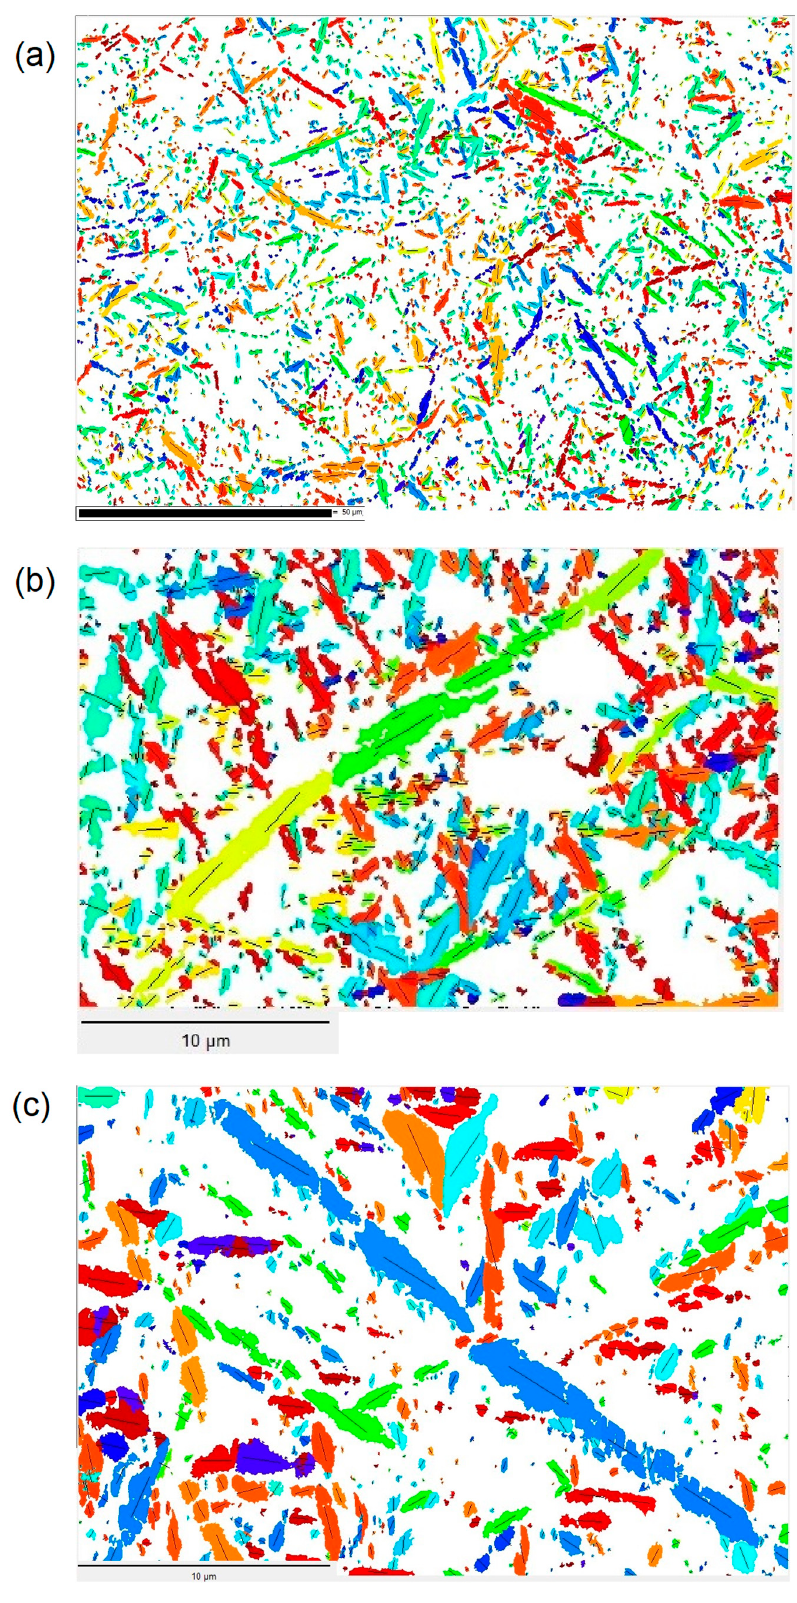
Figure 17. Traces of the planes (10 1 (cid:3364) ) B19 ′ on the EBSD maps acquired at ( a ) ×2k, where the scale bar is 50 µ m, and ( b , c ) × 10k, where the scale bar is 10 µ m. The map in ( a ) is that already shown in Figure 4. The traces are automatically plotted with ARPGE.